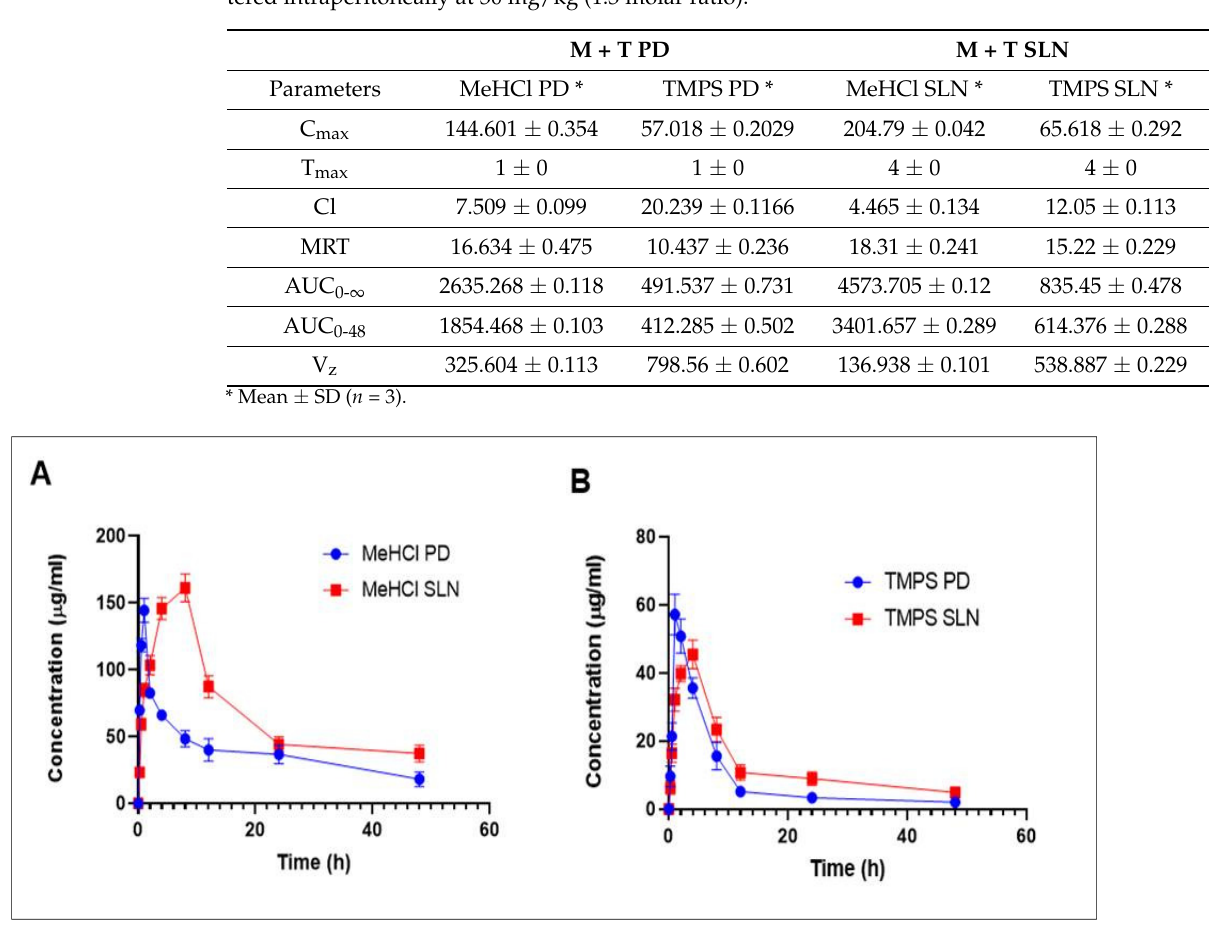
Figure 10. Plasma concentration-time profile of MeHCl + TMPS PD and MeHCl + TMPS SLNs administered intraperitoneally at 30 mg/kg (1:3 molar ratio) ( A ) Plasma concentration-time profile of MeHCl PD & MeHCl SLN ( B ) Plasma concentration-time profile of TMPS PD & TMPS SLN. The data is represented in mean ± SD ( n =